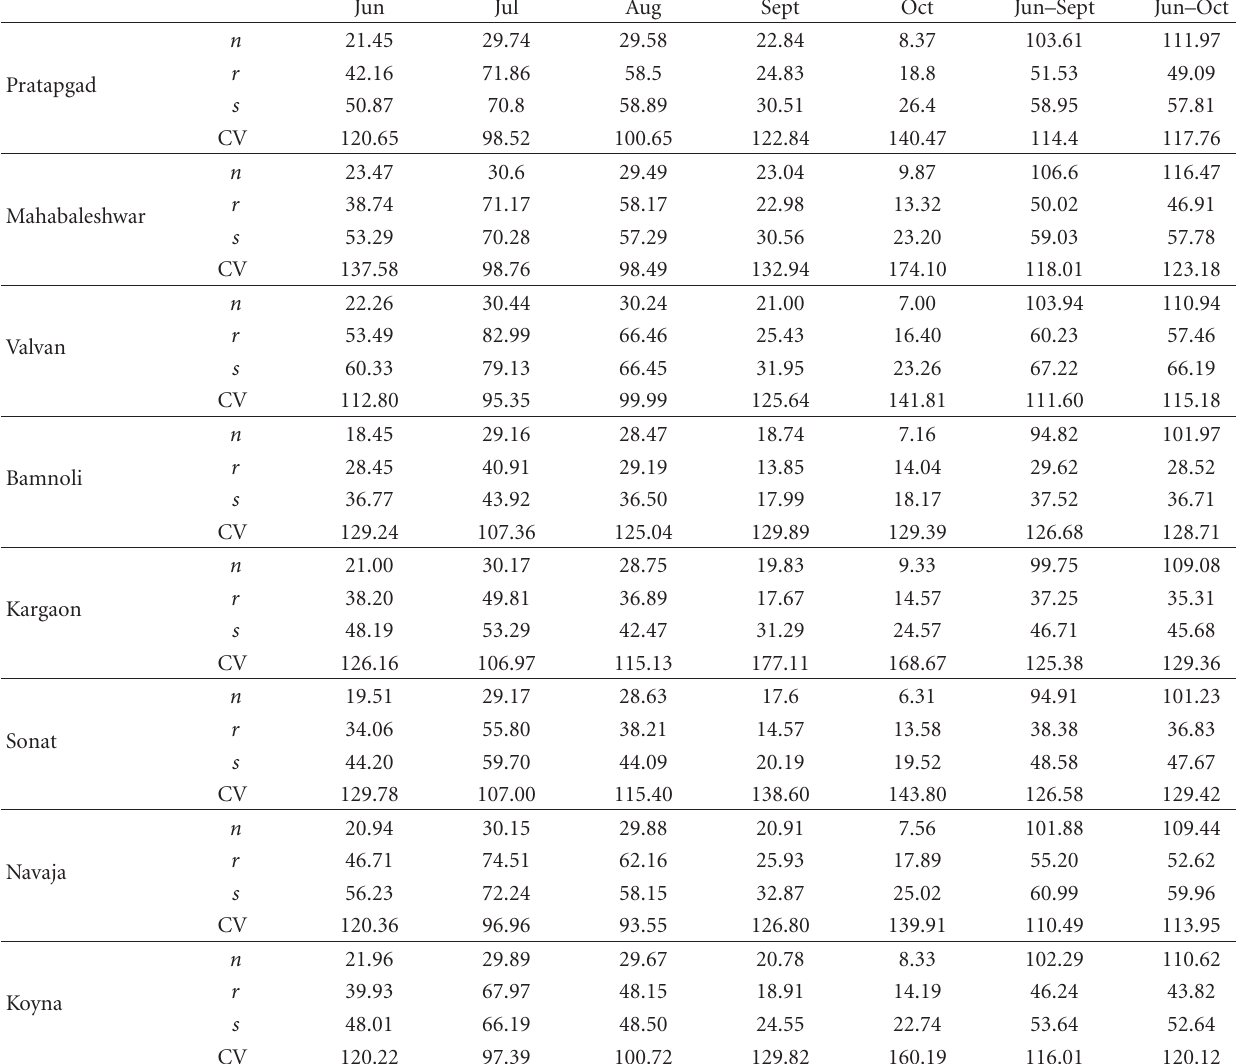
Table 3: Statistical parameters of rainfall series of eight stations in the Koyna catchment. Jun Jul Aug Sept Oct Jun–Sept